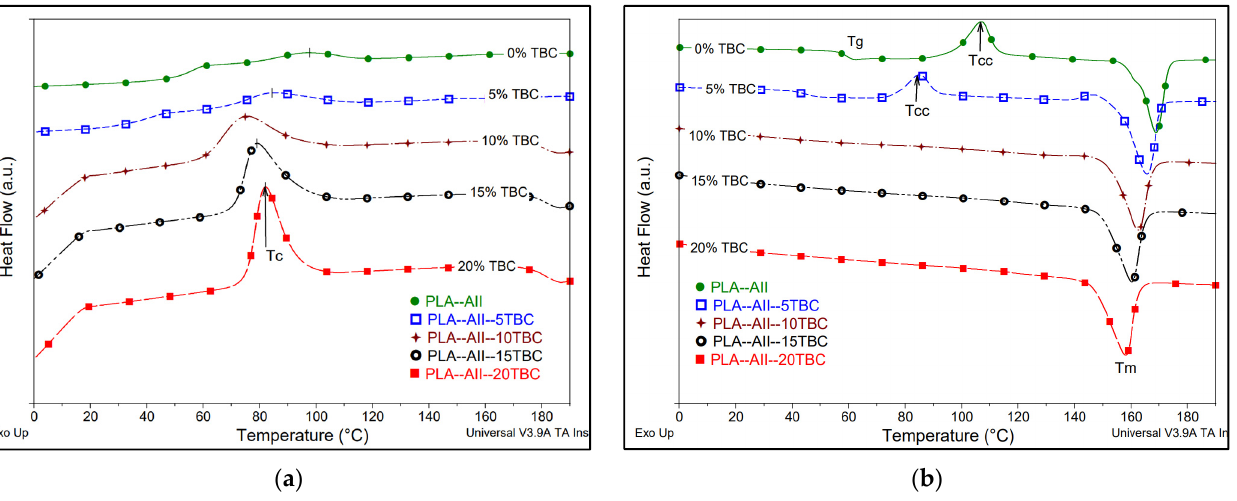
Figure 6. ( a , b ) Comparative DSC curves of PLA/AII composites with/without plasticizer obtained during ( a ) DSC cooling scans; ( b ) Second DSC heating scans (rate of cooling/heating of 10 °C/min).